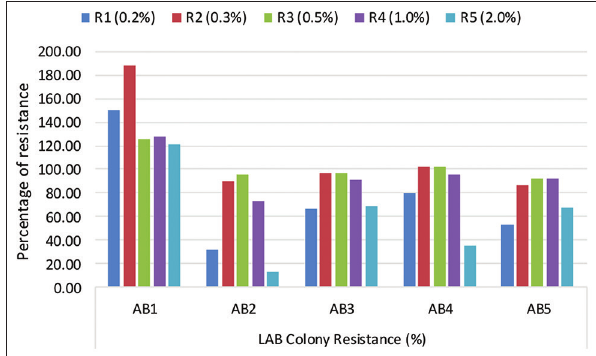
Figure-3: Percentage of five lactic acid bacteria isolates resistance at several concentrations of bile